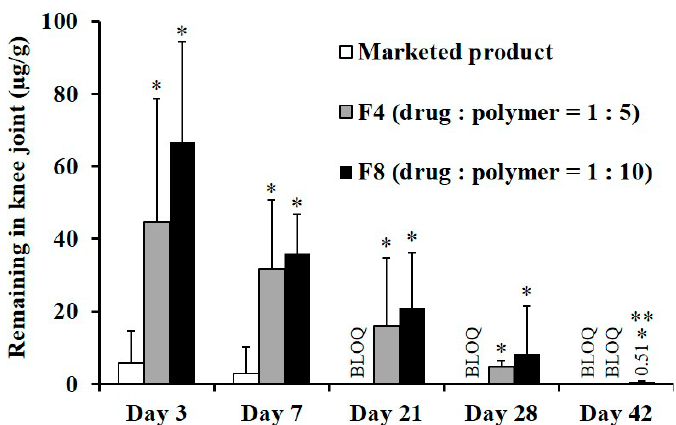
Figure 6. TA remains in rat joint tissue following IA administration of the marketed product, F4, and F8 at a dose of 125 μ g of TA per knee; Notes: Vertical bars represent mean ± SD ( n = 6). Statistical analysis was performed using the one-way ANOVA test; * significantly different from the marketed product ( p < 0.05), ** significantly different from F4 ( p < 0.05). BLOQ value of LC-MS/MS analysis was determined to 0.2 ng/mL.